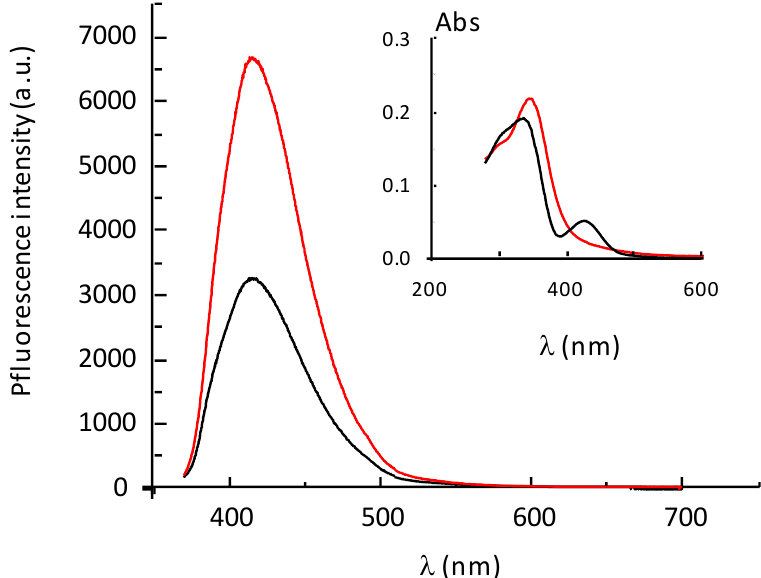
Figure 5. Uv-vis absorption (inset) and fluorescence emission spectra of P797 at 10 − 5 mol.dm − 3 in acetonitrile + TBABF 4 0.1 mol.dm − 3 . Black curve: before electrolysis (Species A in Scheme 2). Red curve: after a 1 Faraday/mole oxidation at 0.7 V/SCE (Species B in Scheme 2). Excitation wavelength λ ex = 350 nm for the fluorescence spectra.